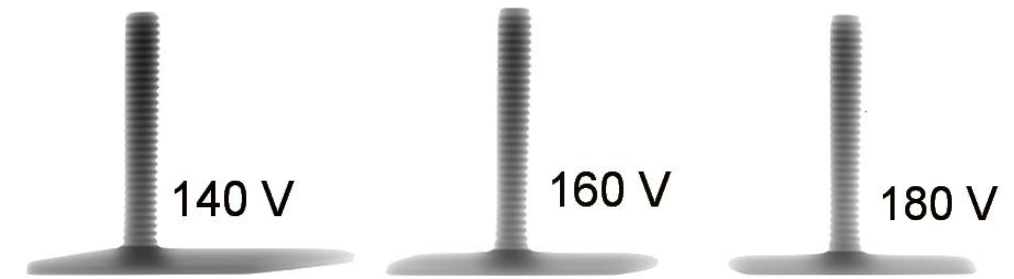
Figure 15. Radiographic inspection of 140 V, 160 V, and 180 V welding voltage applied samples, 100 kV, 1200 µA, 20 s, 50 cm.